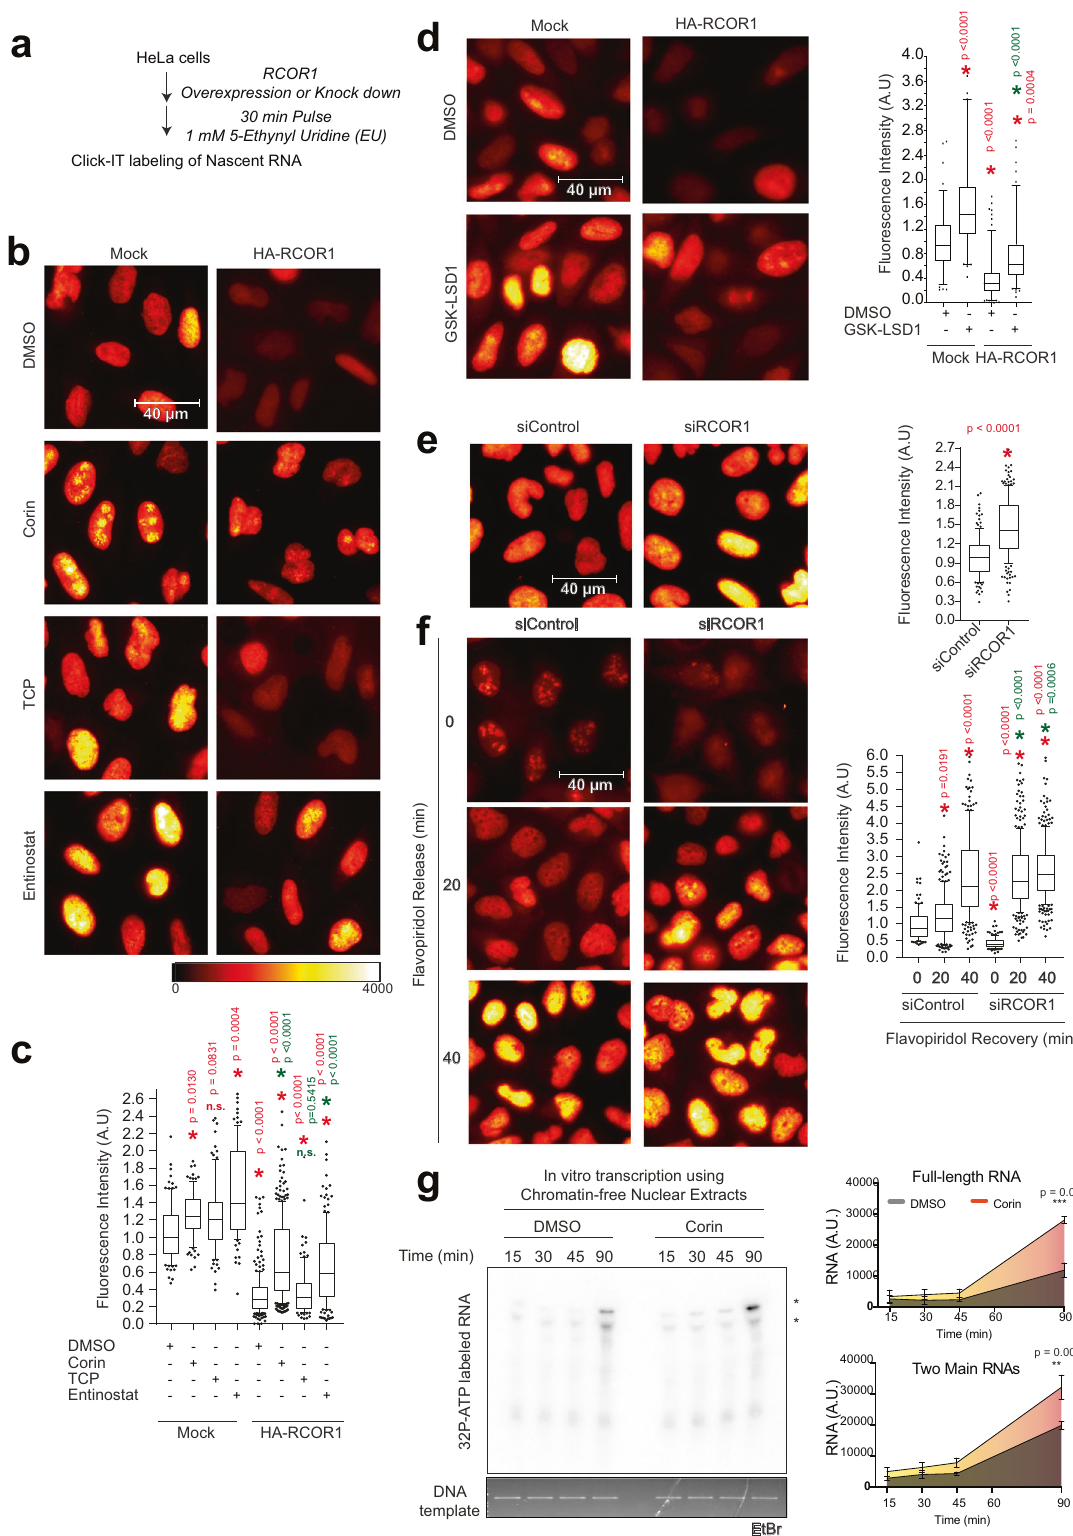
Enrichment of RCOR1 at accessible and transcribed chroma- tin . When chromatin is digested by MNase, the digestion reaction preferentially occurs at nucleosome-free regions. Kinetically, the fi rst products are chromatosomes (nucleosomes containing his- tone H1), which are then further digested to produce free nucleosomes, releasing histone H1 and short sequences of linker